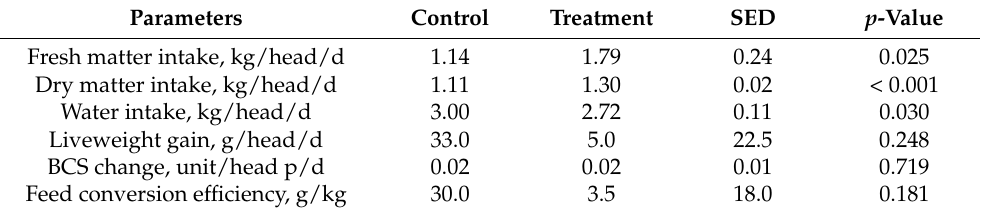
Table 2. Effects of feeding a diet containing 20% grape marc on productivity of merino